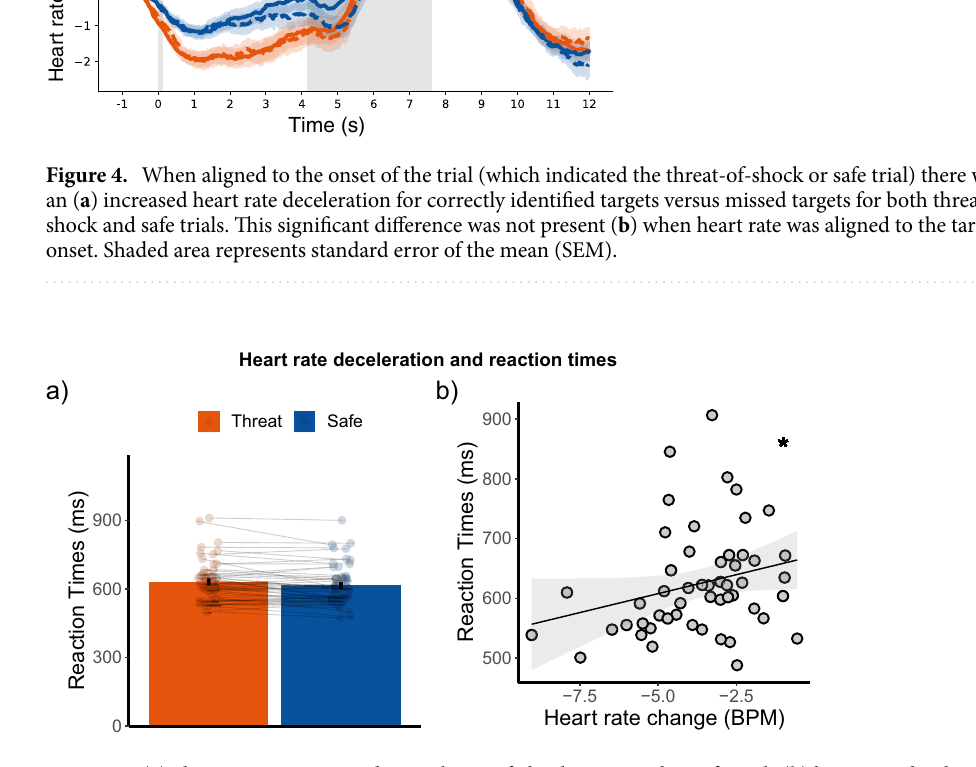
Figure 5. ( a ) Slower reaction times during threat-of-shock compared to safe trials ( b ) heart rate deceleration associated with faster reaction times which did not significantly differ between threat-of-shock and safe trials. Error bars represent + /− standard error of the mean